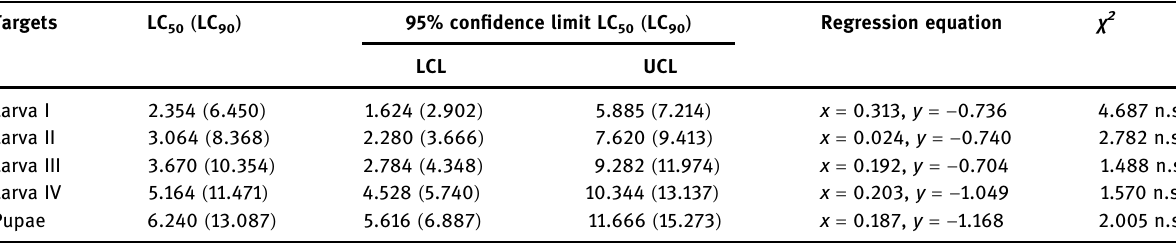
Table 3: Biotoxicity of Z. mays silk - synthesized AgNPs against larvae and pupae of Ae. aegypti